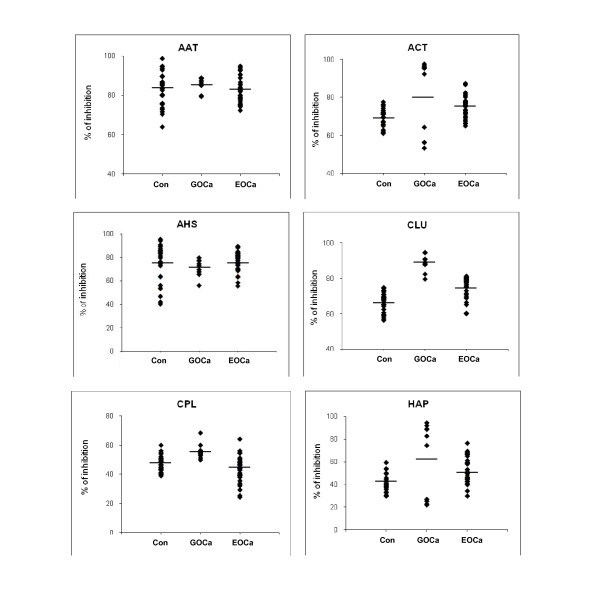
Analysis of serum protein expression by competitive ELISA. Competitive ELISA was preformed using sheep/goat anti-human ACT, AHS, CLU, CPL, AAT and HAP as primary antibodies. Analyses were performed in triplicate. Relative expression of serum proteins in GOCa and EOCa patients is defined as percentage (%) of up- or down regulation from that of negative controls.